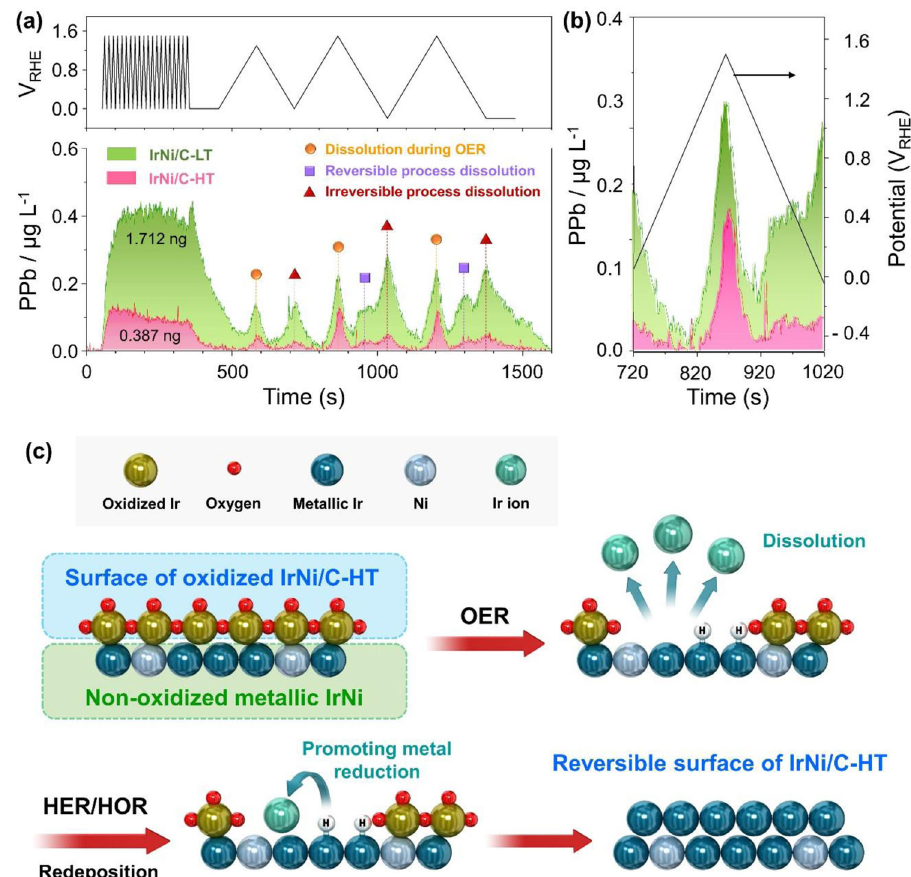
Fig. 5 Mechanistic study of the reversible catalyst surface by in situ /operando ICP of IrNi/C-LT and IrNi/C-HT. a Real-time Ir dissolution pro fi le of IrNi/ C-LT and IrNi/C-HT under a representative experimental sequence. b The Ir dissolution pro fi le during CV in the scan range between 0 and 1.5 V RHE . c Reversible surface schematic of IrNi/C-HT under OER- HER